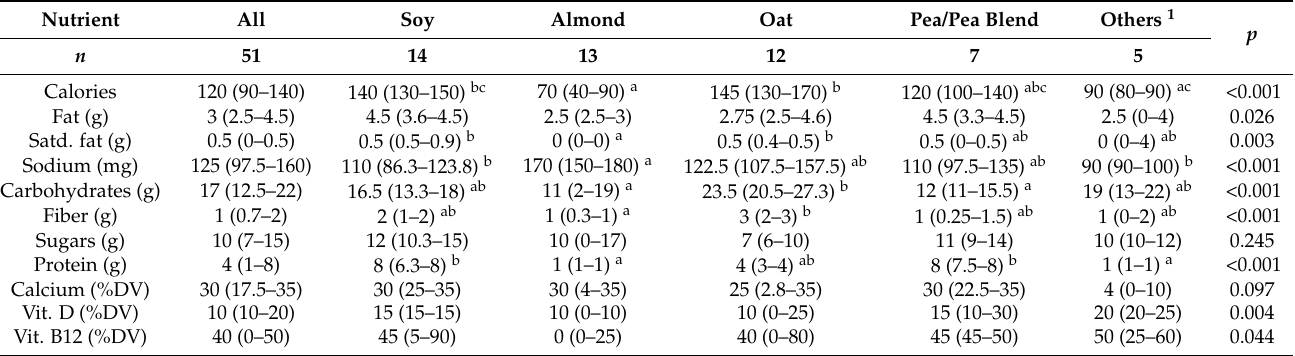
Table 1. Median (Q1–Q3) values of nutrients in non-dairy single-serve beverages/serving for all base